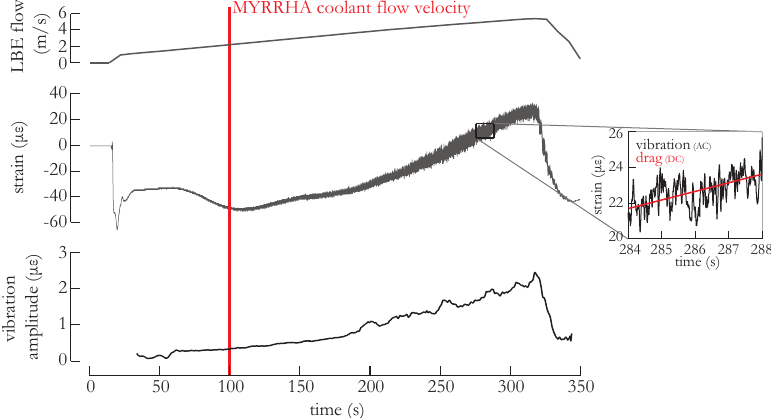
Figure 5. ( Top ): The LBE flow velocity during the course of the test procedure; middle: Corresponding average strain values as measured with all the FBGs on all fuel pins; ( Bottom ): rms value of the strain AC component of the middle figure; inset: Illustration of the high-pass filtering applied to the strain measurements to eliminate the drag ( i.e. , the DC component ( red )) and obtain the vibration (AC